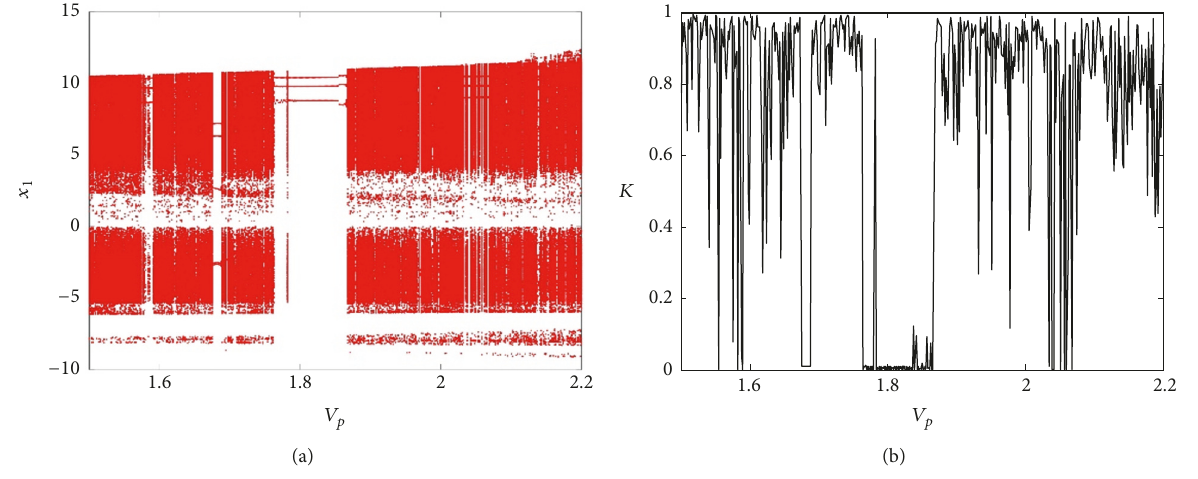
Figure 4: (a) Bifurcation diagram ( 𝑉 𝑝 versus 𝑥 1 ). (b) 𝐾 versus 𝑉 𝑝